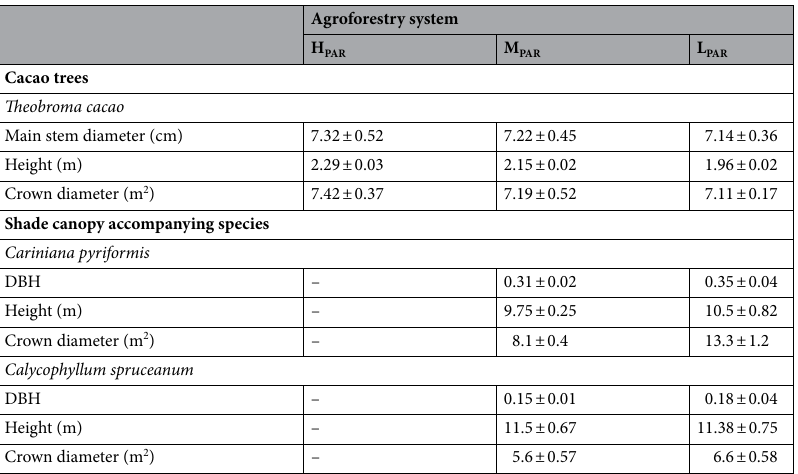
Table 1. Different measurements done in cacao trees ( Theobroma cacao ) and accompanying species in each of the agroforestry systems (AFs) analyzed in this study. These AFs mainly differ in the density and species shading the cacao crop and thus in the incident radiation the cacao crop receive and the associated microclimatic changes. Tree measurements are, main stem diameter (cacao; measured at 20 cm above ground) or diameter at breast height (DBH, rest of the trees), tree height, and crown diameter. Main characteristics of AFs and their legend are described in the methods section and Fig.